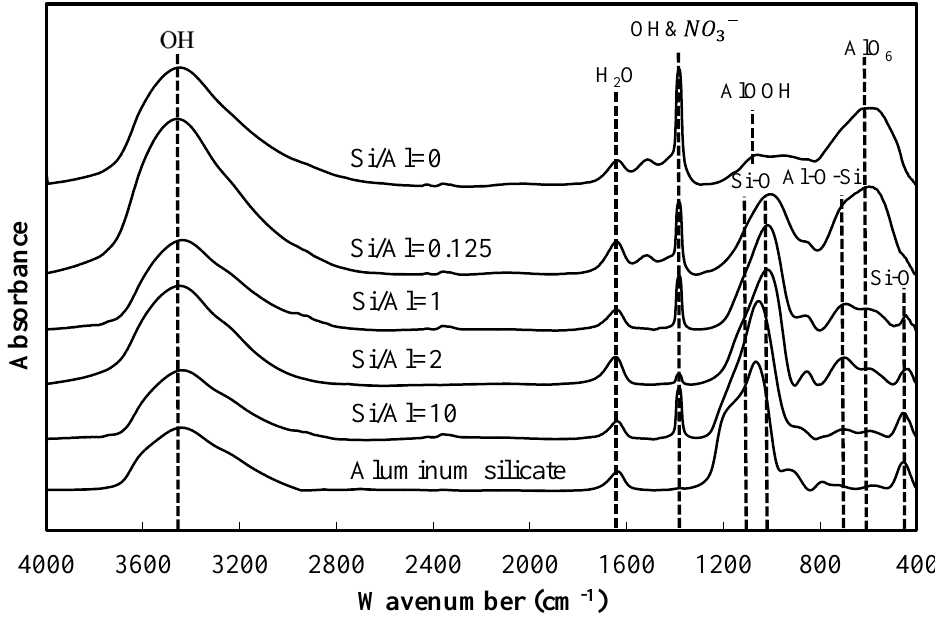
Figure 5. FT-IR spectra of silicate co-precipitated residues at pH 9 at an initial aluminum concentration of 1.48 mmol·dm −3